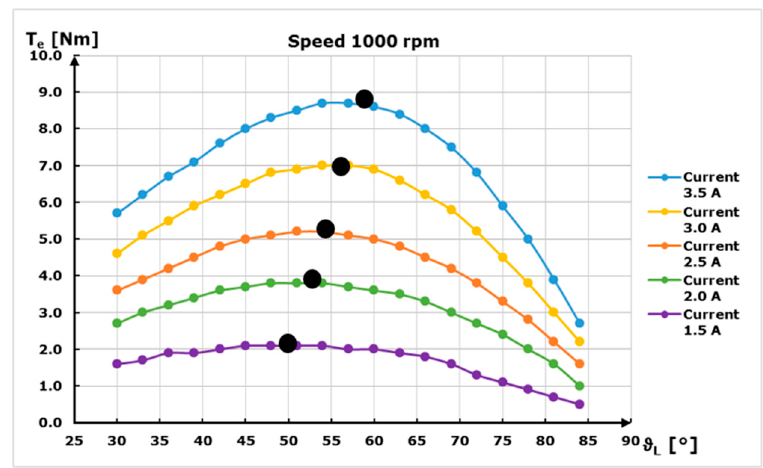
Figure 4. Torque versus load angle at 1000 rpm for various phase currents.